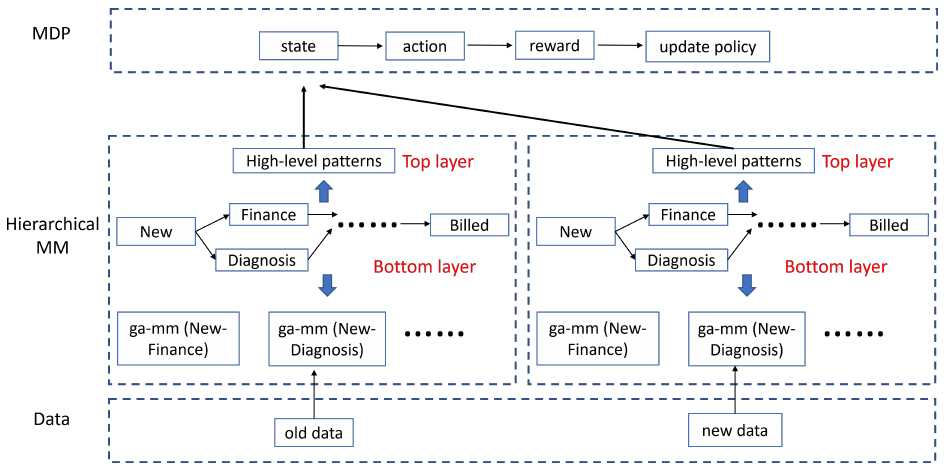
Figure 2. The flow chart of the HMDP